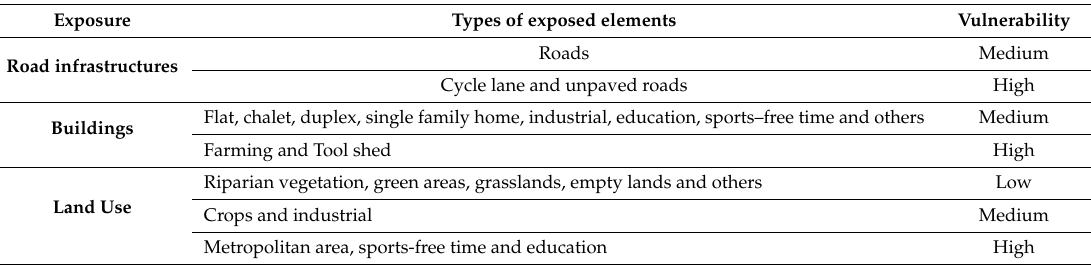
Table 3. Types of exposed elements and vulnerability that they present.